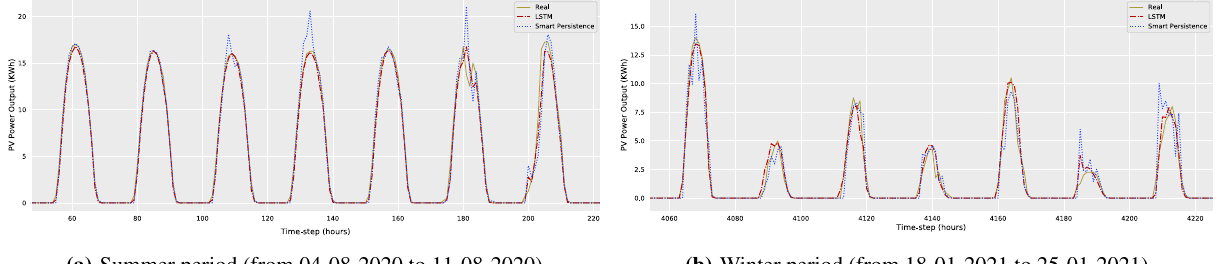
Figure 5. Example illustrating how the solar power forecasting model performs in comparison with the smart persistence model. The horizontal axis indicates the hourly time-step of the evaluation period, while the vertical axis shows the solar power production. The example refers to a randomly selected summer week (between hours 54 and 222 of the validation set, corresponding to 04-08-2020 and 11-08-2020) and a randomly selected winter week (between hours 4060 and 4228 of the validation set, corresponding to 18-01-2021 and 25-01-2021) of the evaluation